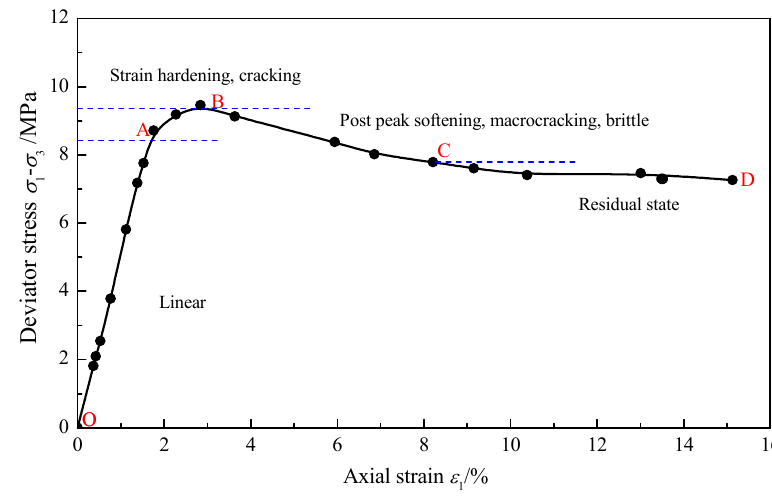
Figure 6. Illustration of a typical complete stress–strain curve under triaxial compression for coal containing gas hydrate.